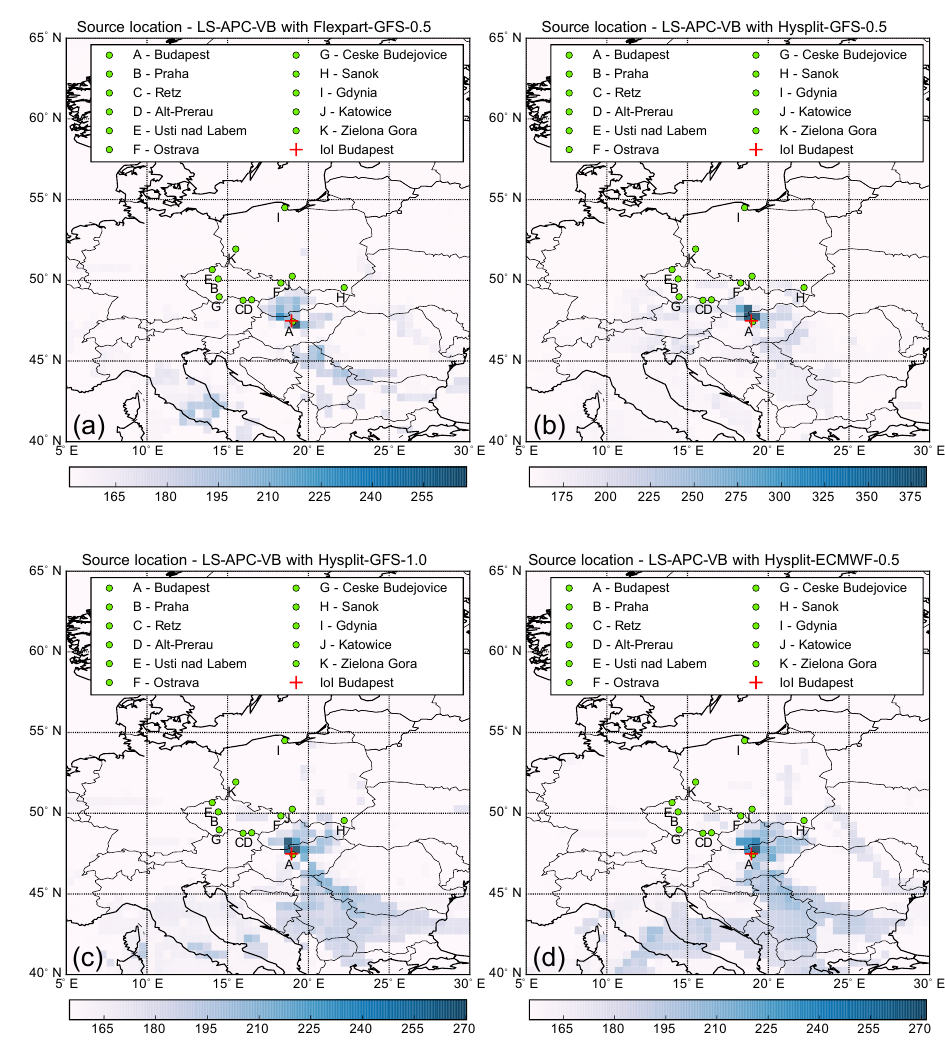
Figure 2. Source location via marginal log-likelihood where the observed data are explained by a release from a grid cell using the LS- APC-VB algorithm for all four tested combinations of dispersion model and meteorological data: Flexpart-GFS-0.5 (a) , Hysplit-GFS-0.5 (b) , Hysplit-GFS-1.0 (c) , and Hysplit-ECMWF-0.5 (d) . The measuring sites (a list is given in Table 1) are displayed using green circles while the location of the Institute of Isotopes (IoI) Ltd. is displayed using a red